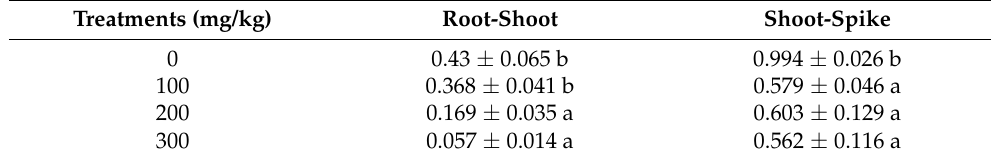
Table 2. Cu transport coefficients of sea